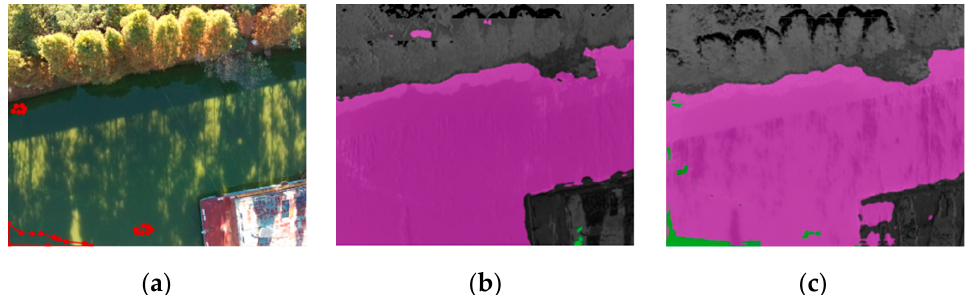
Figure 6. Detection results of different algorithms for shadow scene: ( a ) visible light image; ( b ) de- tection results of NDVI as the feature-extraction method; ( c ) detection results of NDVI sqrt as the fea- ture-extraction method.